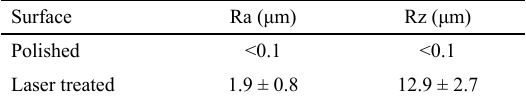
Table 3. Results of roughness parameters.